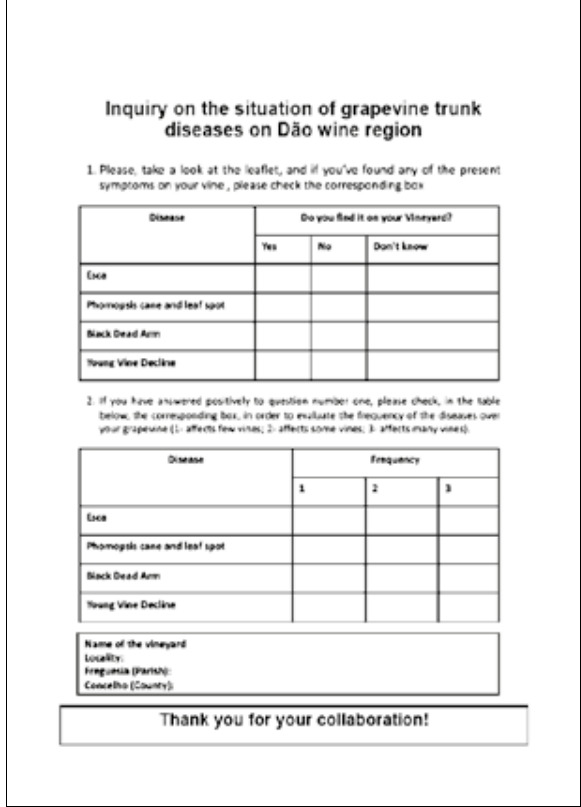
Figure 3. Questionnaire used to evaluate the situation of grapevine trunk diseases in the Dão wine region (English